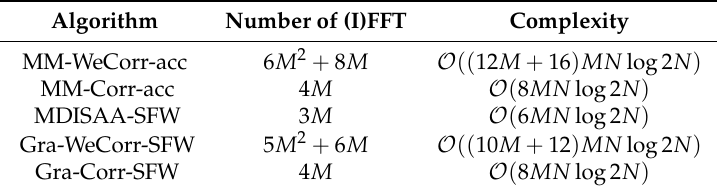
Table 1. The per iteration computational complexities of different